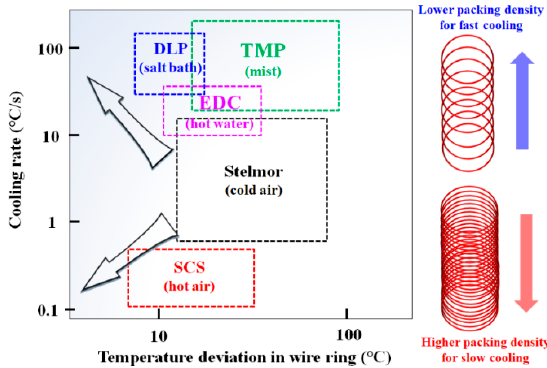
Figure 1. Schematic description of development trend in steel wire rod cooling system [6–12].